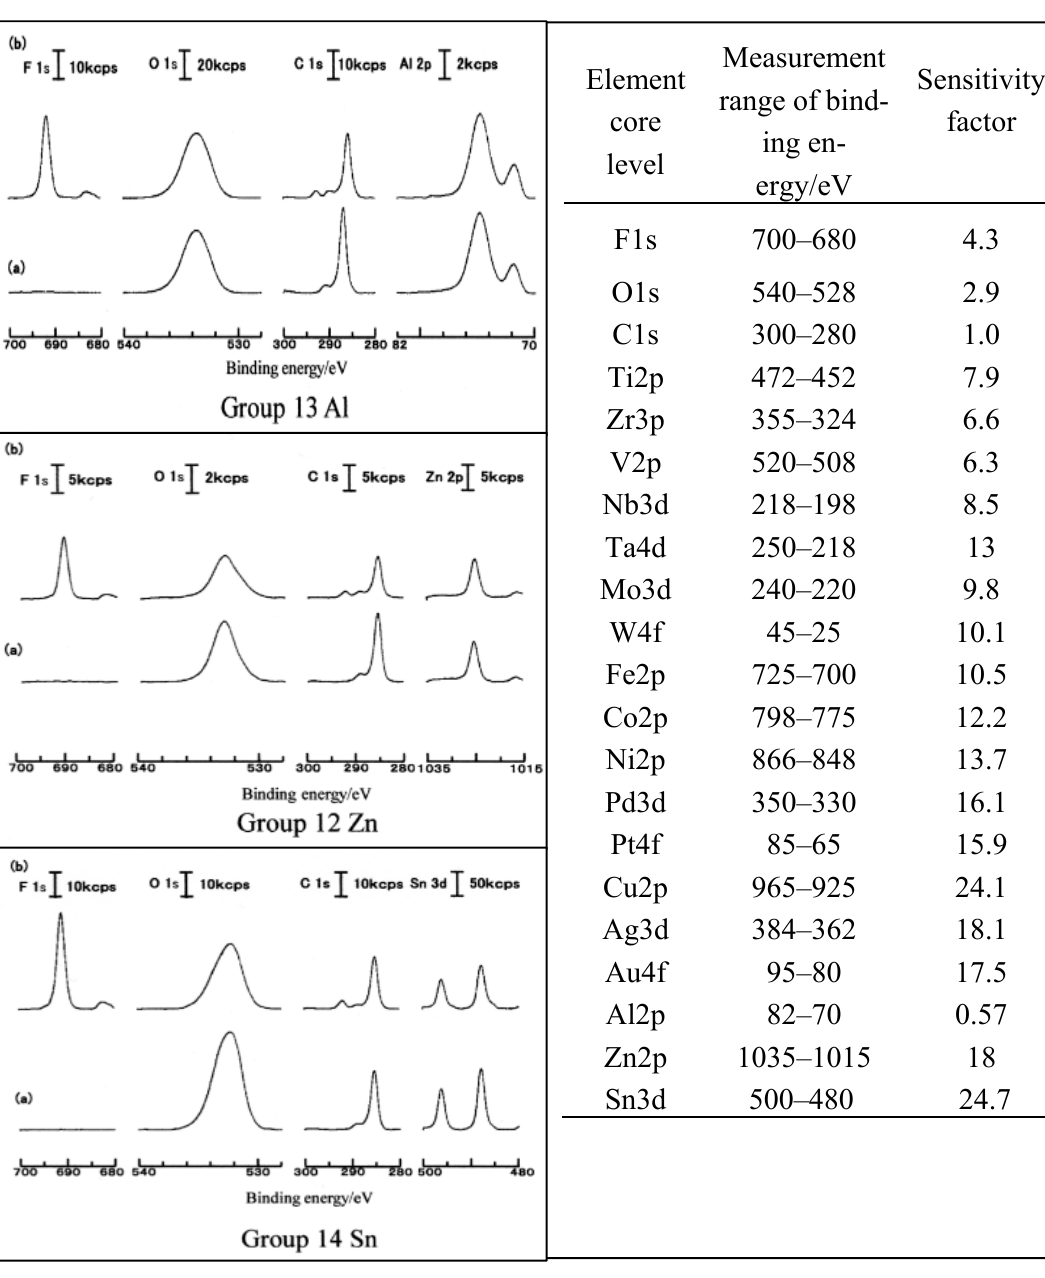
Figure 8. XPS spectra for groups 13 (Al), 12 (Zn), and 14 (Sn) ( a ) before and ( b ) after the TriboEE measurement and the measurement range of binding energy and sensitivity factor for the core level XPS spectra of F1s, O1s, C1s, and 18 kinds of metals.